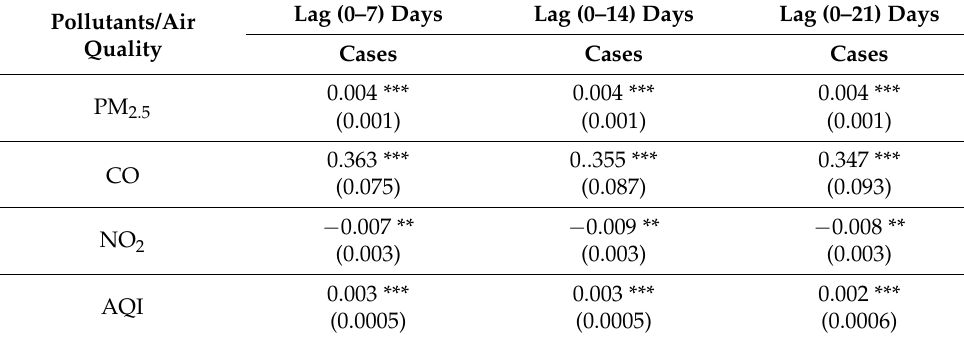
Table 2. Results of the GAM